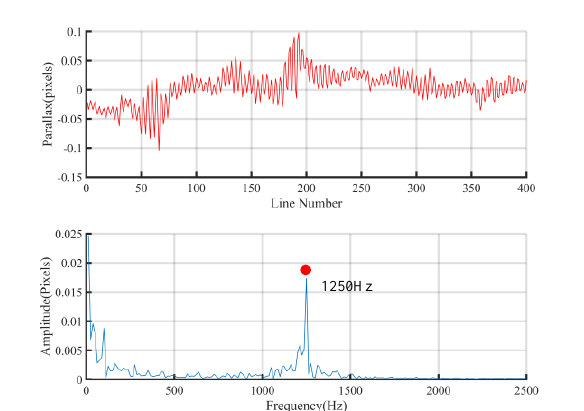
Figure 5. Parallax curve with simulated jitter frequency of 50 Hz, matching window size is 128(cross)* 32(along)